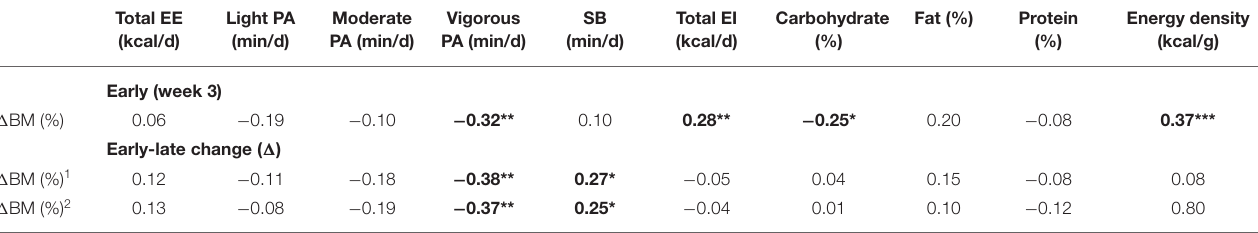
TABLE 1 | Association between early (week three) and early-late change (week three to week 12) movement and eating behaviors and change in body mass (BM) between baseline and week